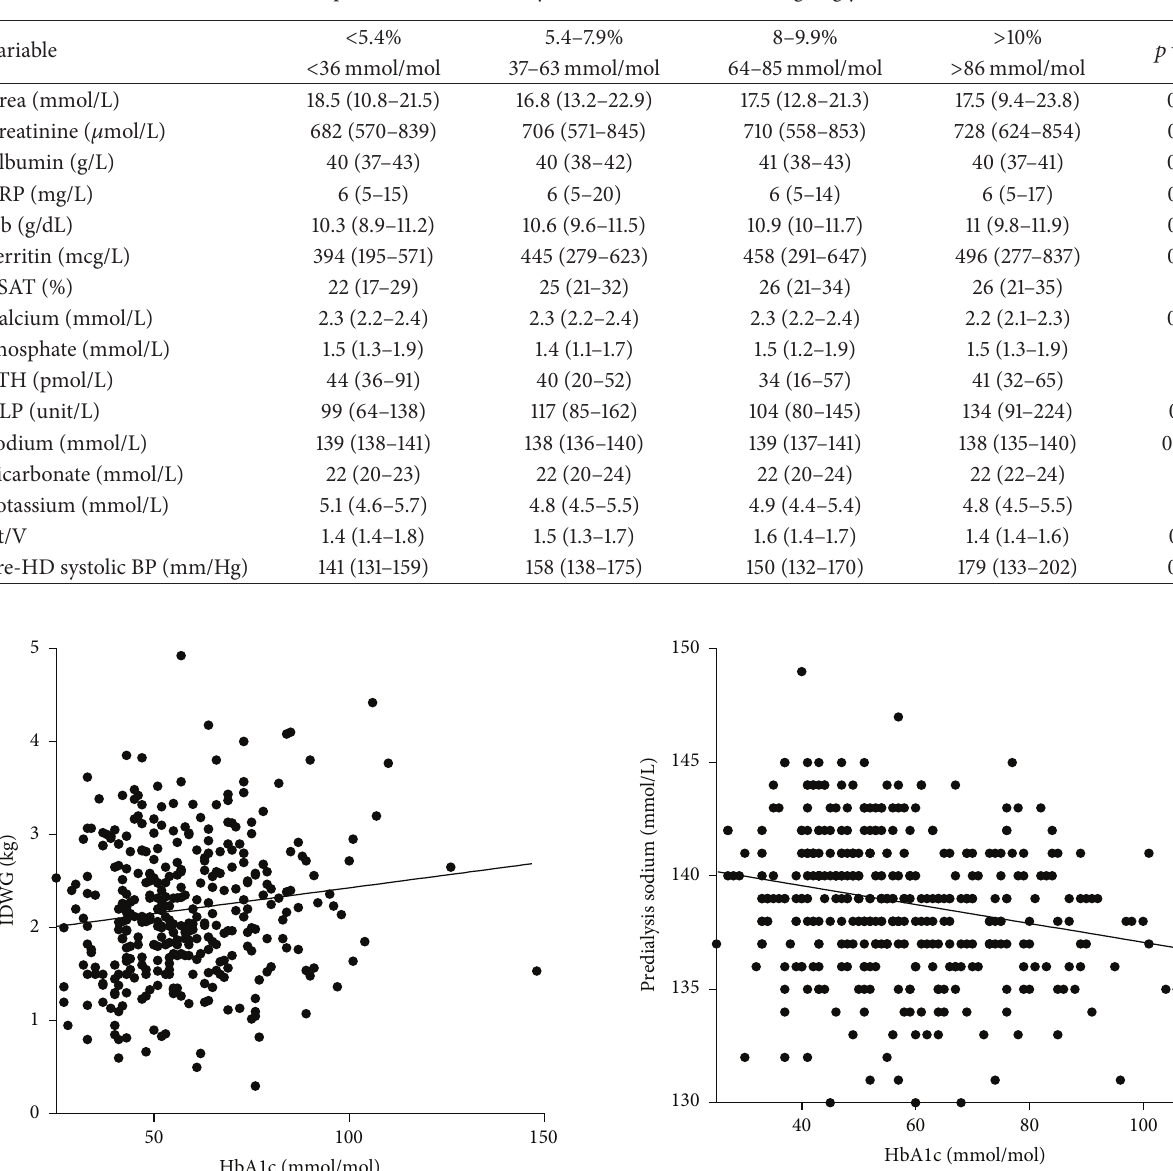
Table 2: Comparison of biochemistry of diabetic cohort according to glycaemic control.